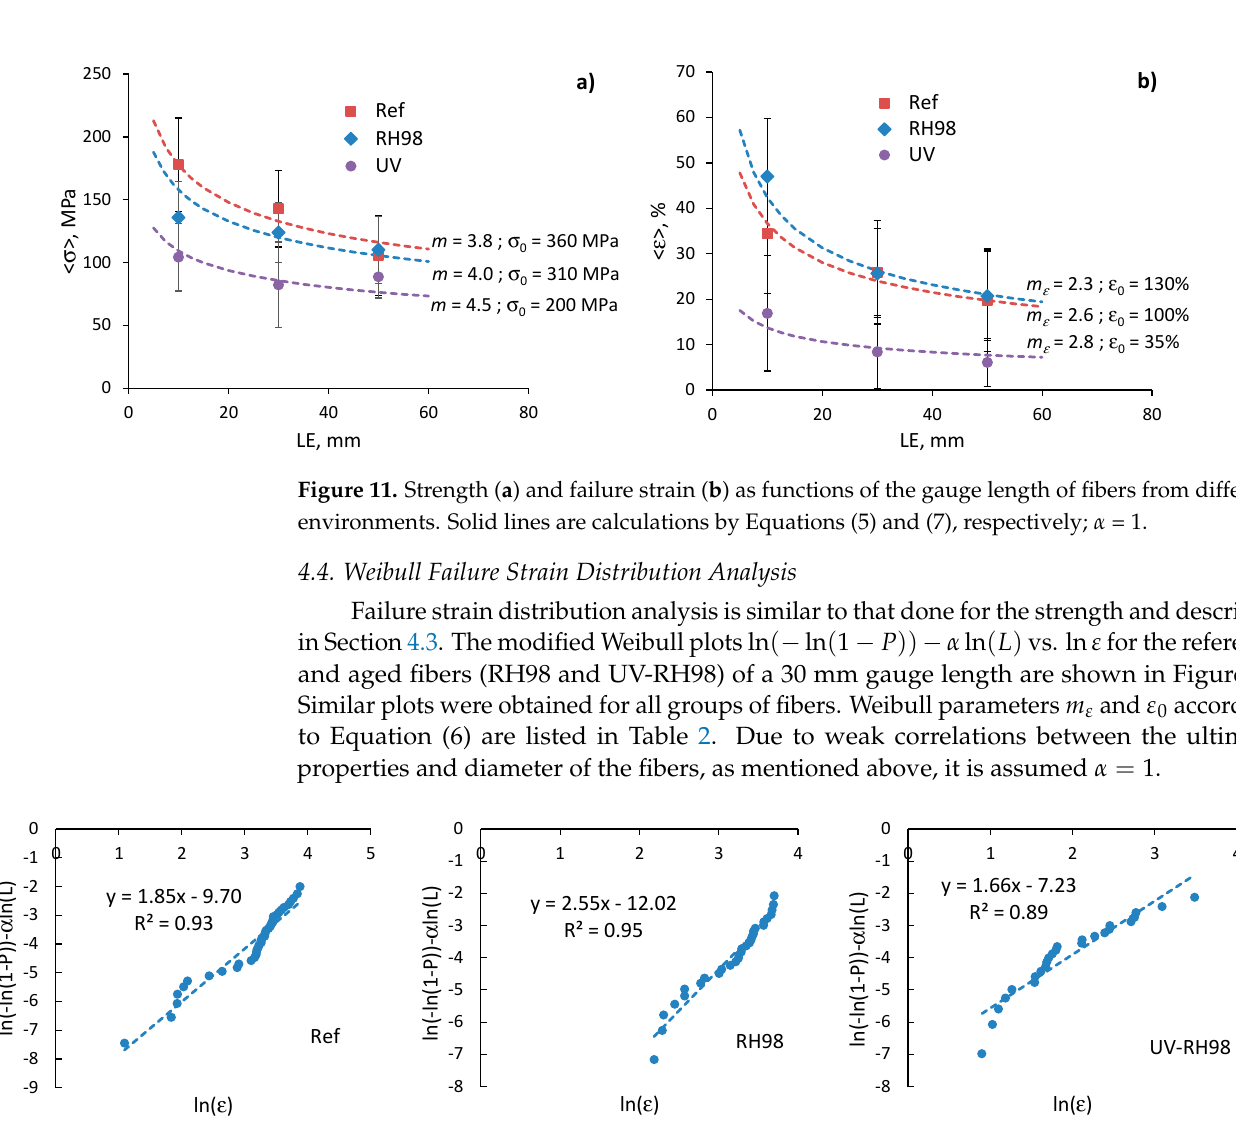
Figure 12. Weibull plots for failure strain of fibers in the reference and aged states at LE = 30 mm. Figure 13 demonstrates the failure strain distribution of the reference and aged fibers.